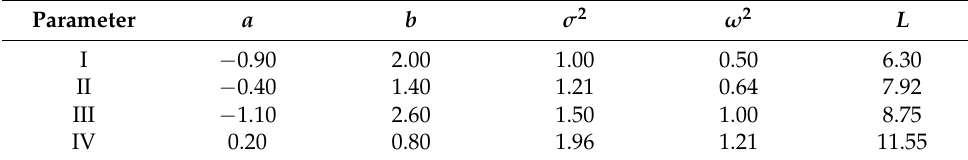
Table 1. Parameter settings used in the simulation study.